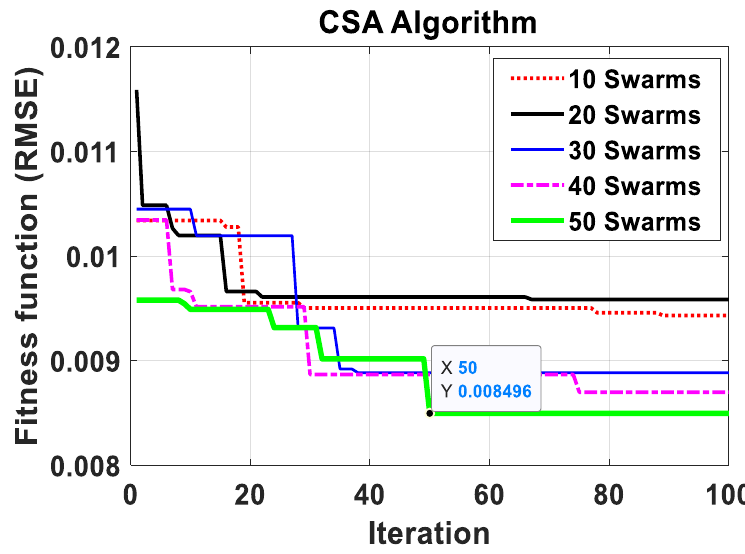
Figure 6. Fitness function of CSA algorithm under five swarm sizes.